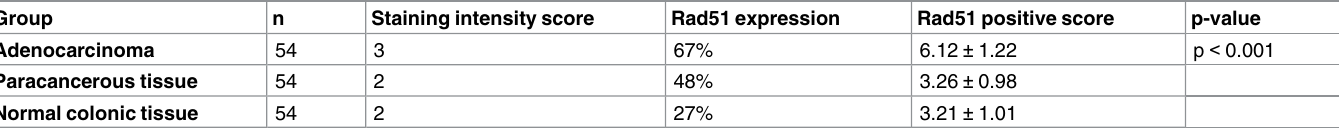
Table 1. Expression of Rad51 in three groups. Group